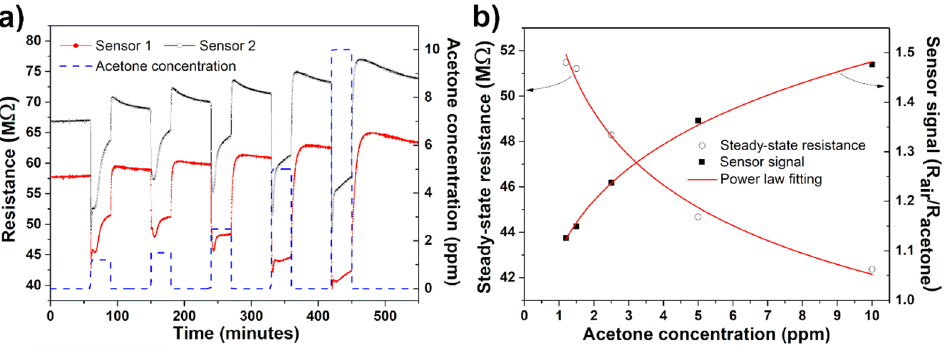
Figure 2. ( a ) SEM image and ( b ) length distribution of the h-MoO 3 microrods. Right inset in ( a ): SEM cross section image of a microrod.